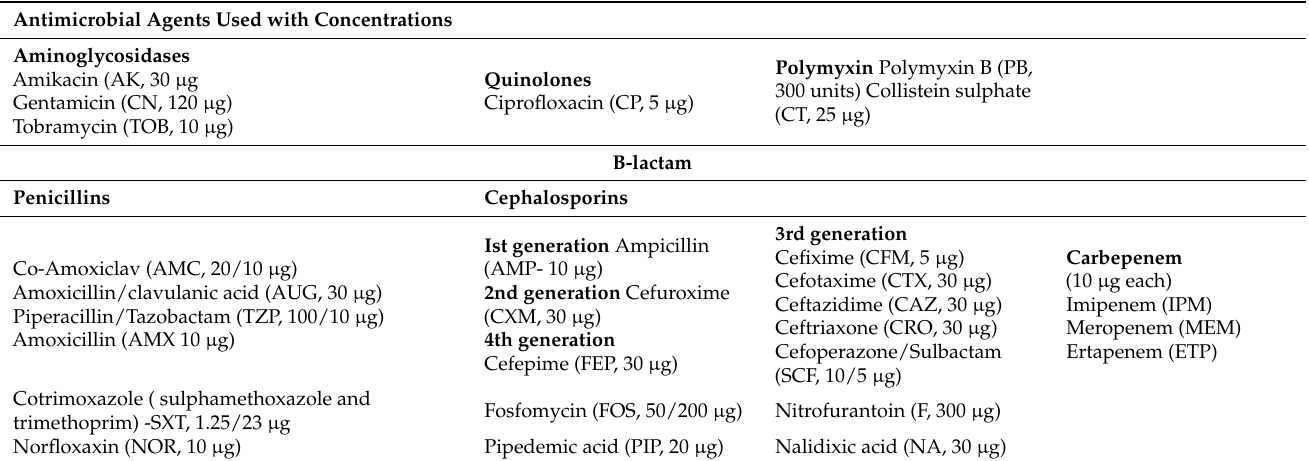
Table 3. Antimicrobials used to categorize antibiotic resistance, intermediate resistance, and sensitiv- ity according to